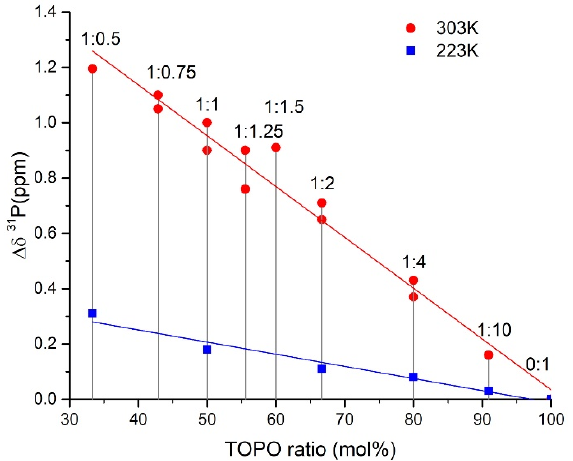
Figure 10. The changes of chemical shifts in 31 P NMR spectra of Li(L)TOPO upon variation of LiL/TOPO ratio (CDCl 3 ).